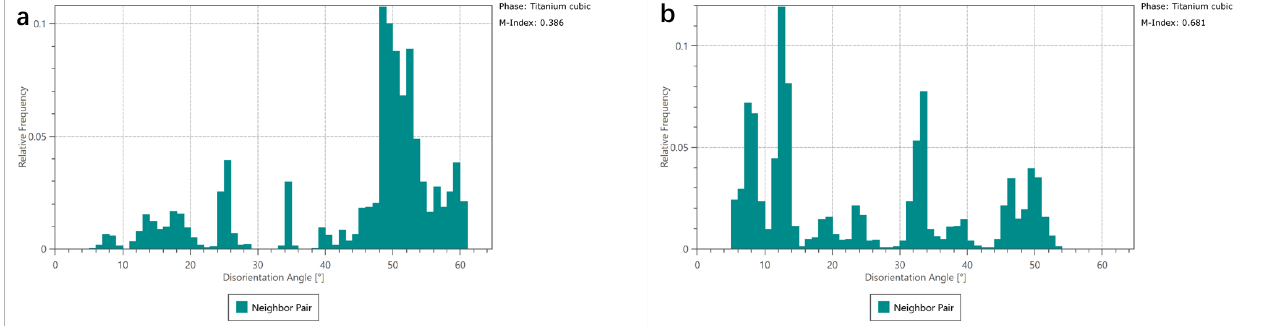
Figure 7. The corresponding misorientation statistics of cubic titanium in the as-deposited area. ( a ) as-LMD, ( b ) LMD+LSPned.